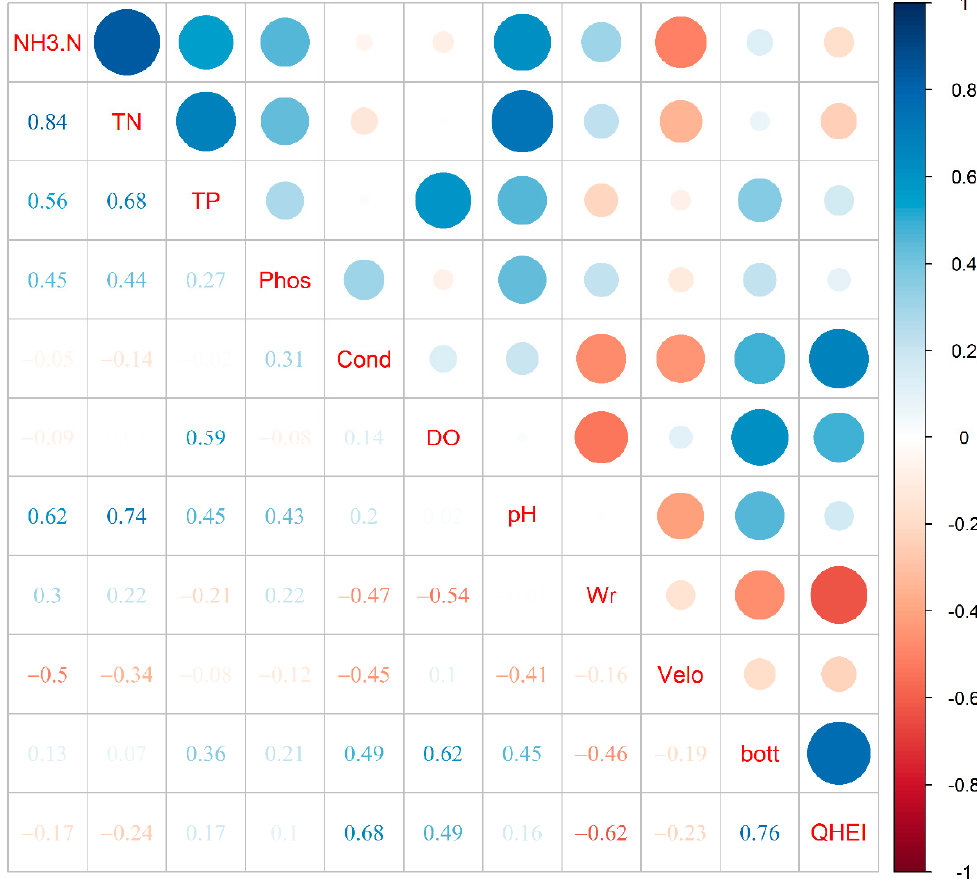
Figure 2. Spearman’s rank correlation coefficient chart of 11 environmental factors.